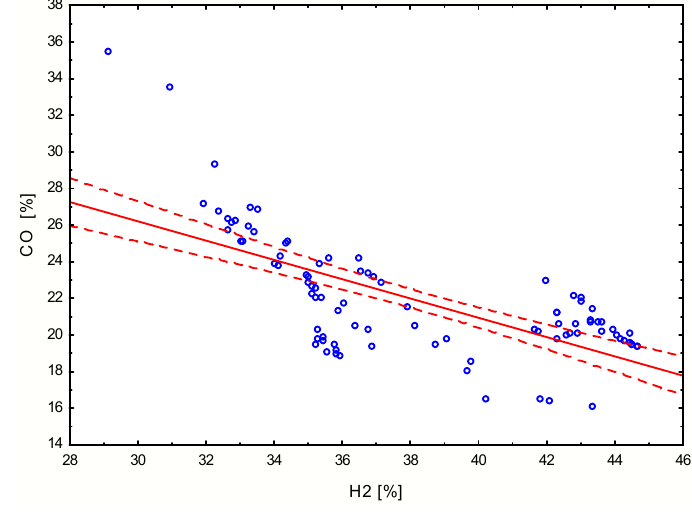
Figure 11. Correlation between percentage of CO and H 2 contents.